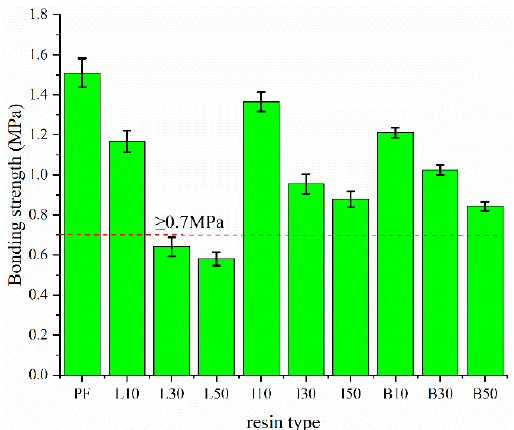
Figure 10. Bonding strength of PF, ALPF, DLPF resins at different lignin substitutions.